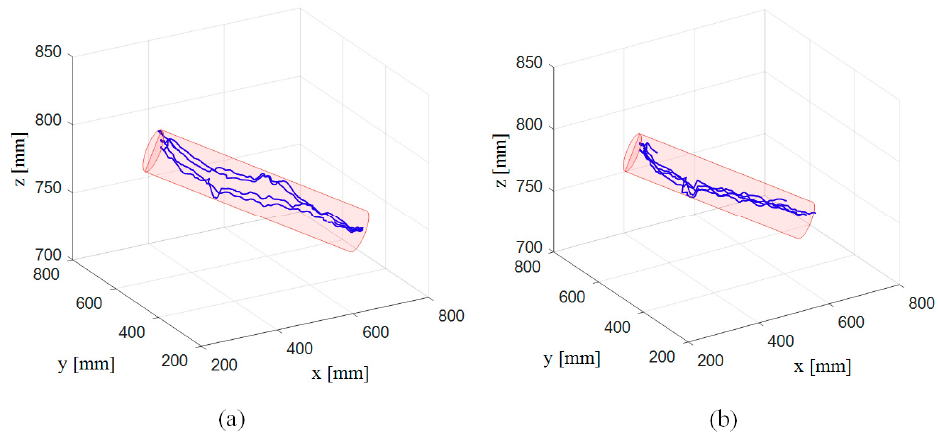
Figure 7. Tracking results of the experiments for ( a ) Subject A and ( b ) Subject B. Table 1. Identified results of uncertain parameters of the exoskeleton working with Subject A.